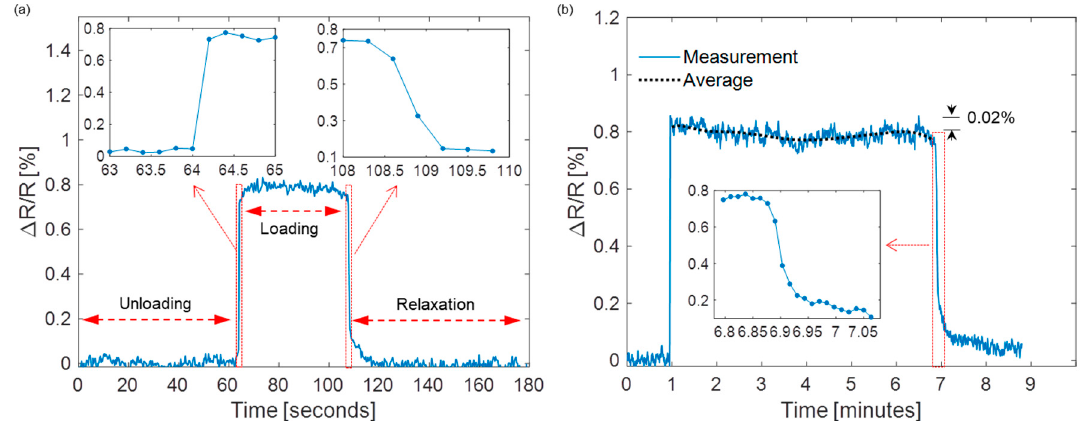
Figure 11. The normalized sensor resistance change under static loading conditions for ( a ) ~45 s and